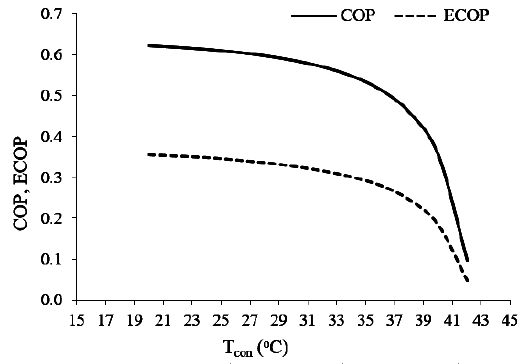
Figure 11. Effect of T con on COP and ECOP.